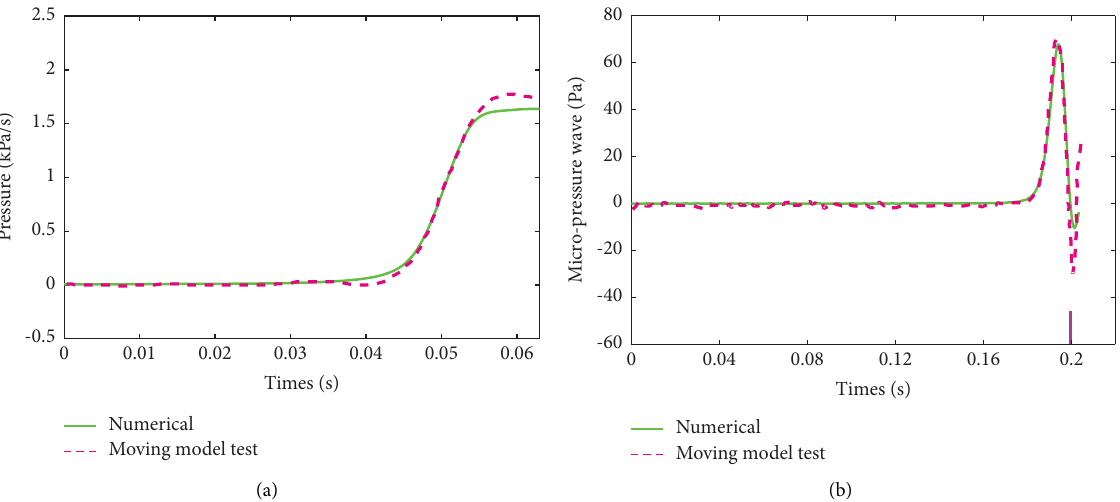
Figure 5: Comparisons of pressure curves obtained by numerical simulation and the experimental test. (a) Initial compression waves. (b) Micropressure waves.